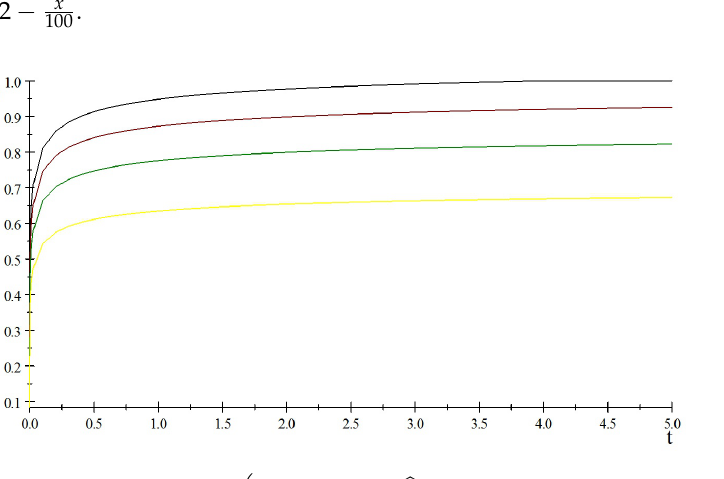
(cid:16) Figure 2. The plot of y for (cid:98) α = 0.2897983, (cid:98) β = 25, q = 0.5, u ( x ) = − 4, b ( x ) = 0.2 − Figure 3 displays the plot of y for (cid:98) α = 0.2897983, (cid:98) β = 25, q = 1, u ( x ) = − 4, b ( x ) = . 0.2 − x 100